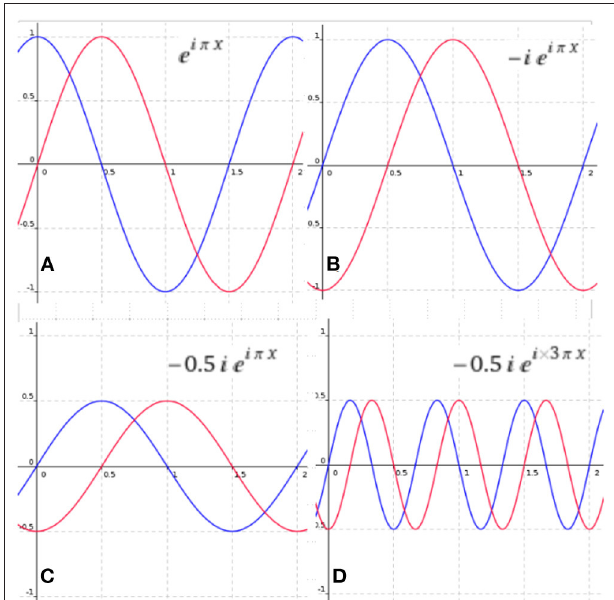
FIGURE 2 | Modifying the parameters of an analytic sinusoid with amplitude 1 phase 0 and frequency π . The sinusoid in red represents the imaginary part of the complex sinusoid and the blue represents the real part. (A) The original signal, (B) the signal with a phase-shift, (C) the signal with a change of amplitude and phase-shift, and (D) a signal with a change of amplitude phase and